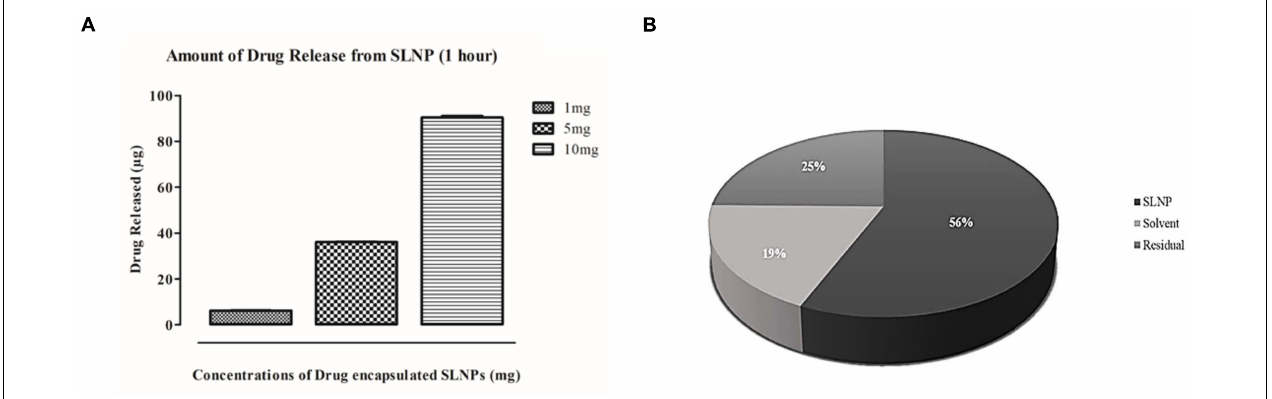
FIGURE 5 | Drug release and entrapment efficiency has been analyzed with HPLC. (A) Histogram representing diosgenin release from solid lipid nanoparticles after an hour. Bars show concentration-dependent diosgenin release. (B) Pie chart representing percent concentrations of diosgenin present/entrapped in solid lipid nanoparticles, formulation solvent (unentrapped) and residue in syringe filter showing diosgenin is entrapped in solid lipid nanoparticles at higher concentration (56%) then in residue (25%) and solvent have the least concentration of diosgenin